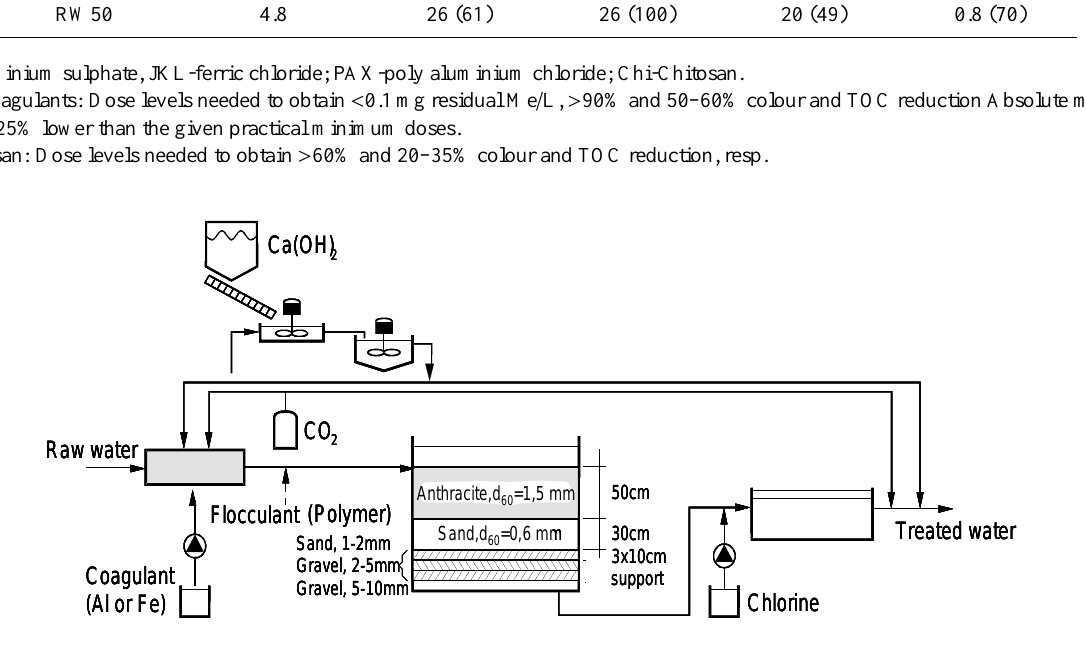
Figure 3. Typical flow scheme for a contact filtration plant for NOM removal in Fig. 2. Coagulation/floc separation Fig. 3. Typical flow scheme for a contact filtration flow schemes plant for NOM removal in Norway